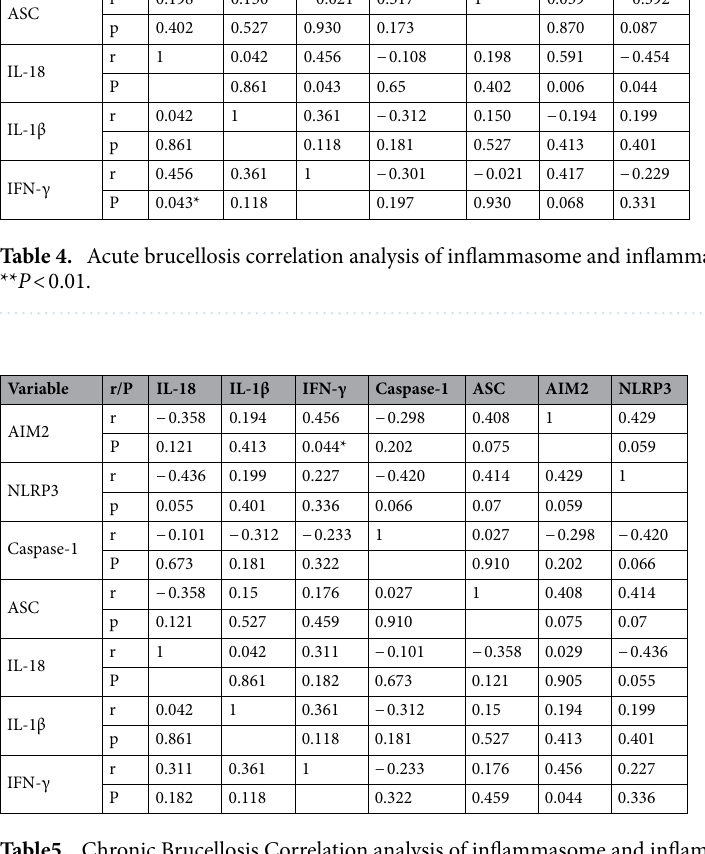
Table5. Chronic Brucellosis Correlation analysis of inflammasome and inflammatory cytokines. * P <